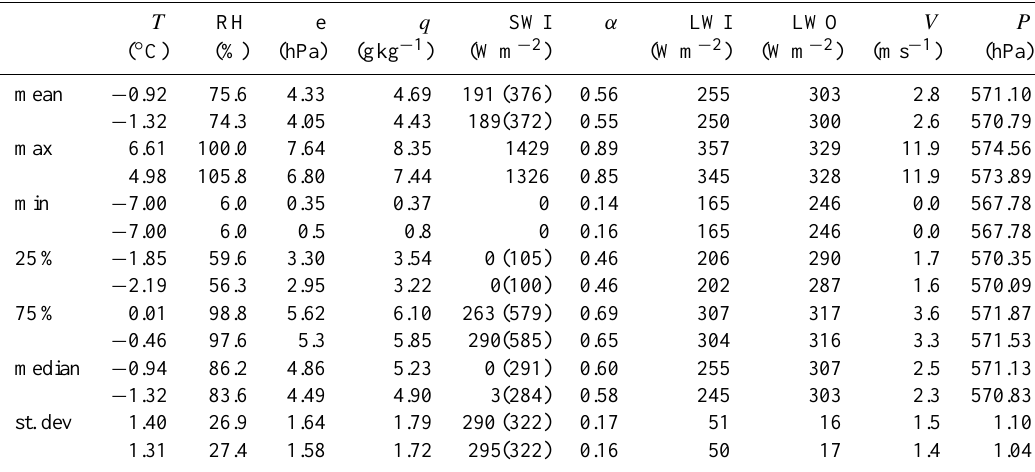
Table 4. Summary of 30min meteorological data measured at LG AWS, computed for all 773 available days between 26 September 2009 and 22 February 2012 (missing data between 25 January and 2 March 2010, and between 20 July and 29 September 2010). Every second row refers to a single annual cycle, 1 October 2010 to 30 September 2011. These data were used to compute the daily values shown in Fig. 2 and Table 2. Abbreviations are given in the text in Sect. 2.1 and values in parentheses for the SWI parameter were computed on daytime values